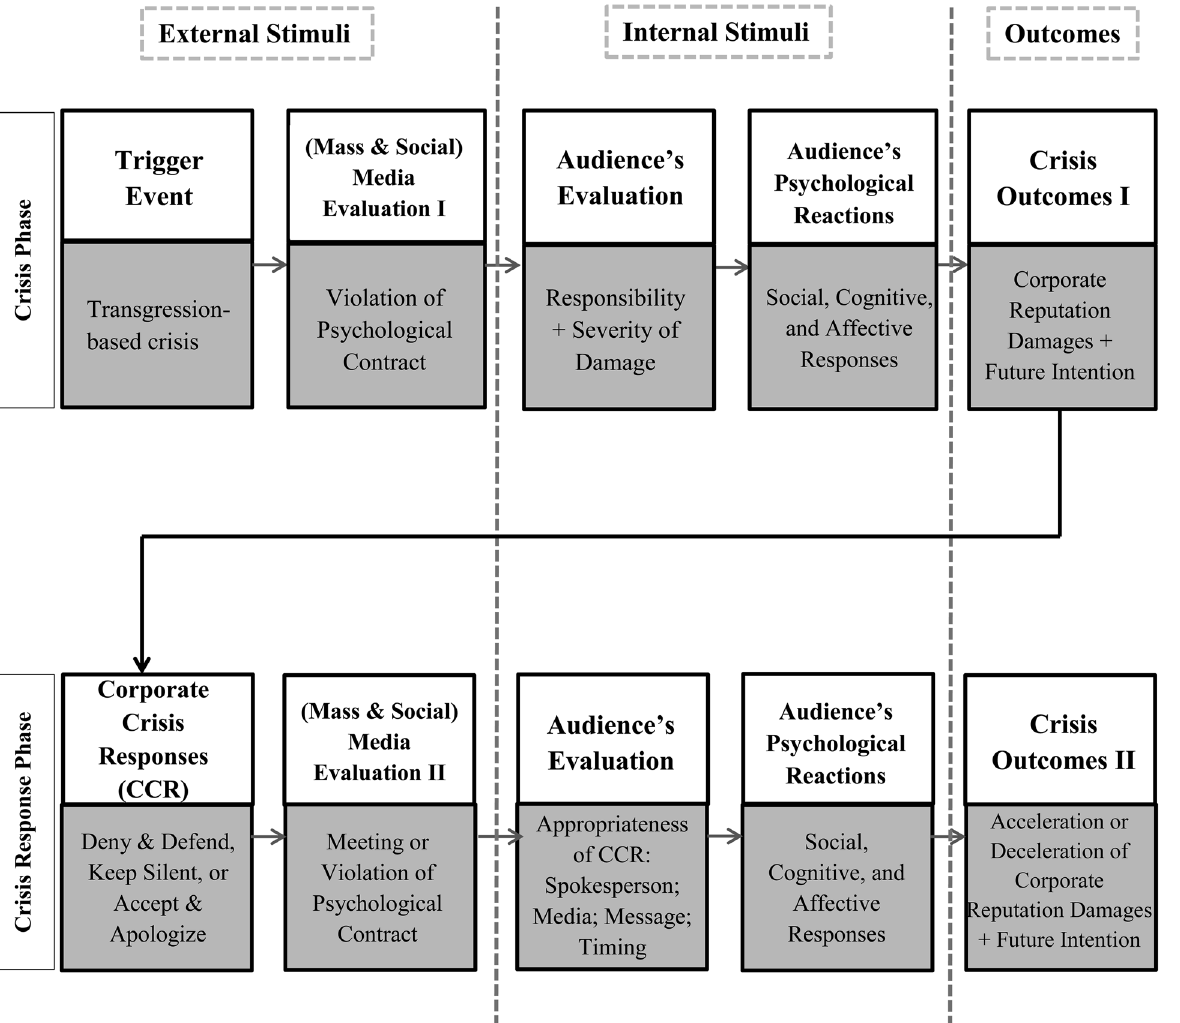
Fig 5. The audiences ’ psychological reaction model during and after an organizational crisis and response. Revised from the stakeholder ’ s cognitive model for information processing during and after organizational crises by Fediuk, Coombs, and Botero in 2010. The model shows how an individual is psychologically influenced by external stimuli (crisis trigger event, corporate crisis response, media evaluations), processing the external stimuli internally (evaluations and psychological reactions), and shaping a crisis perception and future behaviors (crisis outcomes). The arrows are directions of the psychological processes and the two dotted vertical lines were drawn to show the boundaries of each of the three areas (external and internal stimuli and outcomes). The two phases refer to how crisis-triggering event and accordingly crisis responses are being processed both inside (internal stimuli) and outside (external stimuli) of an audience's